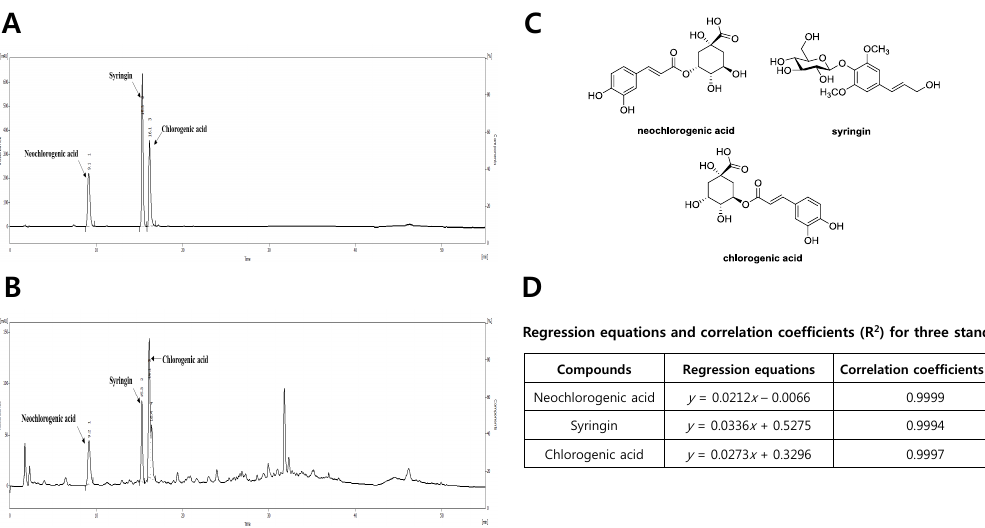
Figure 2. Phytochemical characterization of DM by HPLC analysis. ( A ) HPLC-UV chromatogram for DM; ( B ) HPLC-UV chromatogram for three standard compounds (neochlorogenic acid, syringin, and chlorogenic acid); ( C ) chemical structures of three major compounds in DM. ( D ) Regression equations and correlation coe ffi cients ( R 2 ) for the three standard compounds. HPLC analysis was carried out via gradient elution on a Phenomenex Kinetex C18 column (150 × 4.6 mm, 5 µ m). The flow rate, column oven temperature, and UV wavelength for detection were set at 1 mL / min, 30 ◦ C, and 254 nm,